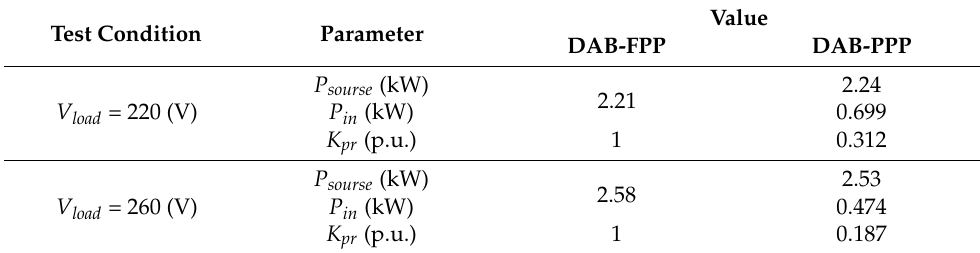
Table 6. Processed power by the DAB-FPP and